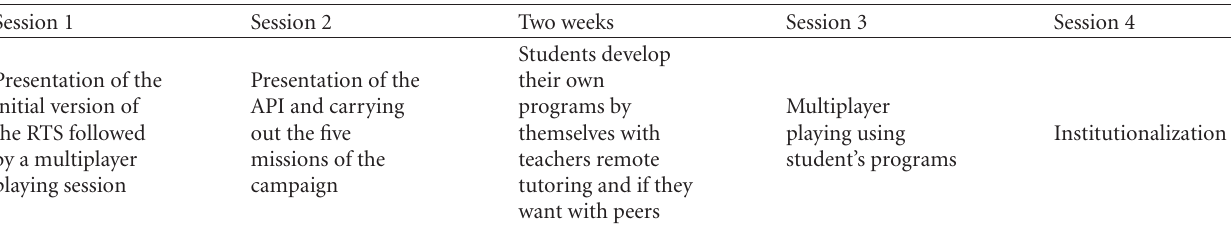
Table 3: Teaching organization